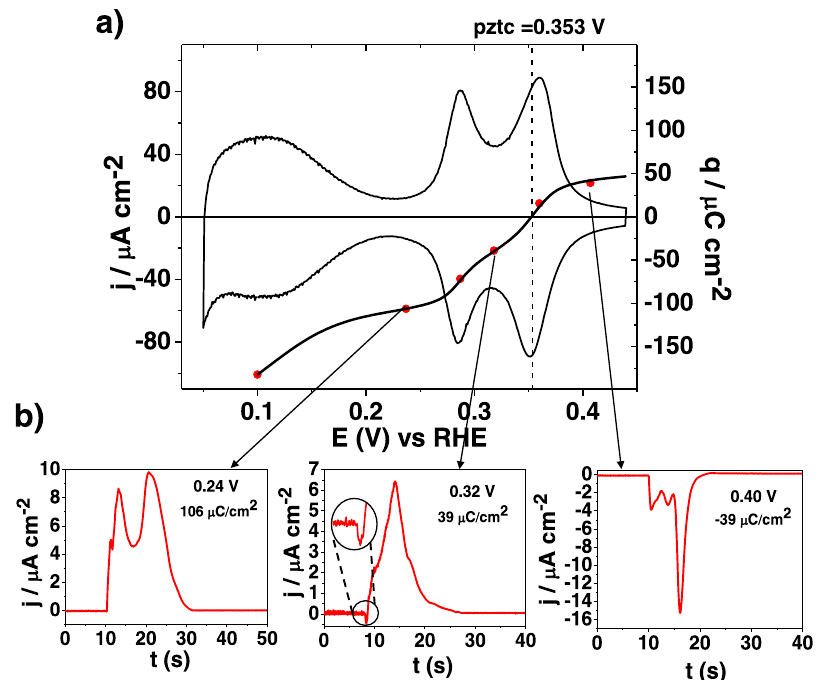
Fig. 2 CO displacement experiments on Pt(311). a Cyclic voltammogram and total charge curve for Pt(311) surface as a function of the potential recorded at a scan rate of 50 mV s − 1 and b CO displacement experiments at different potentials in 0.1 M HClO 4